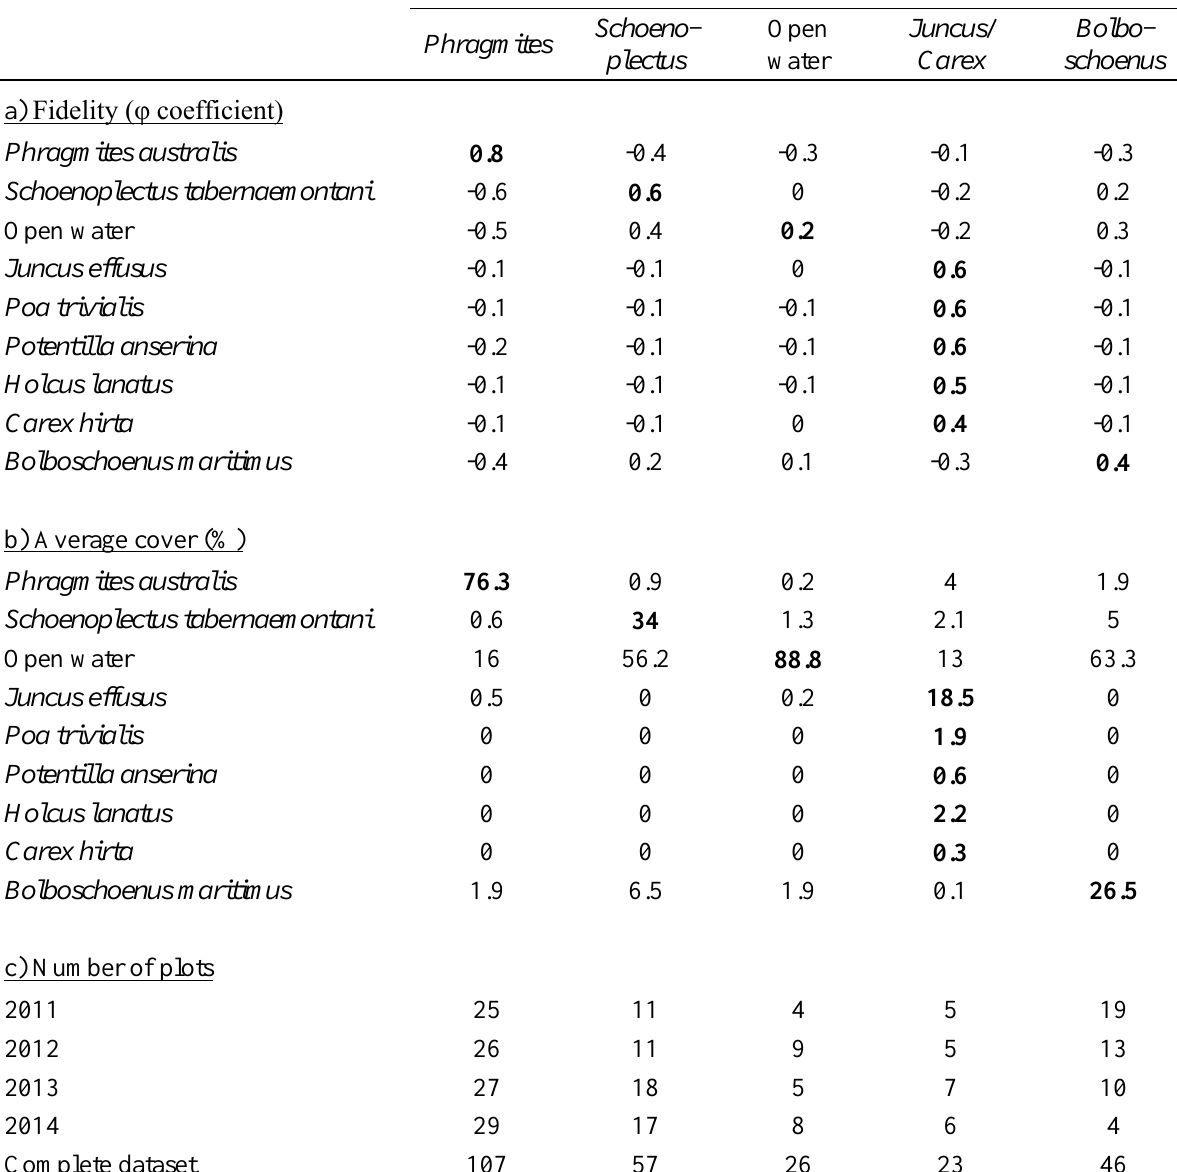
Table 3. Diagnostic species derived from vegetation clustering with fidelity (a) and cover values (b) for each vegetation type. The number of plots classified to each vegetation type throughout the years is given in